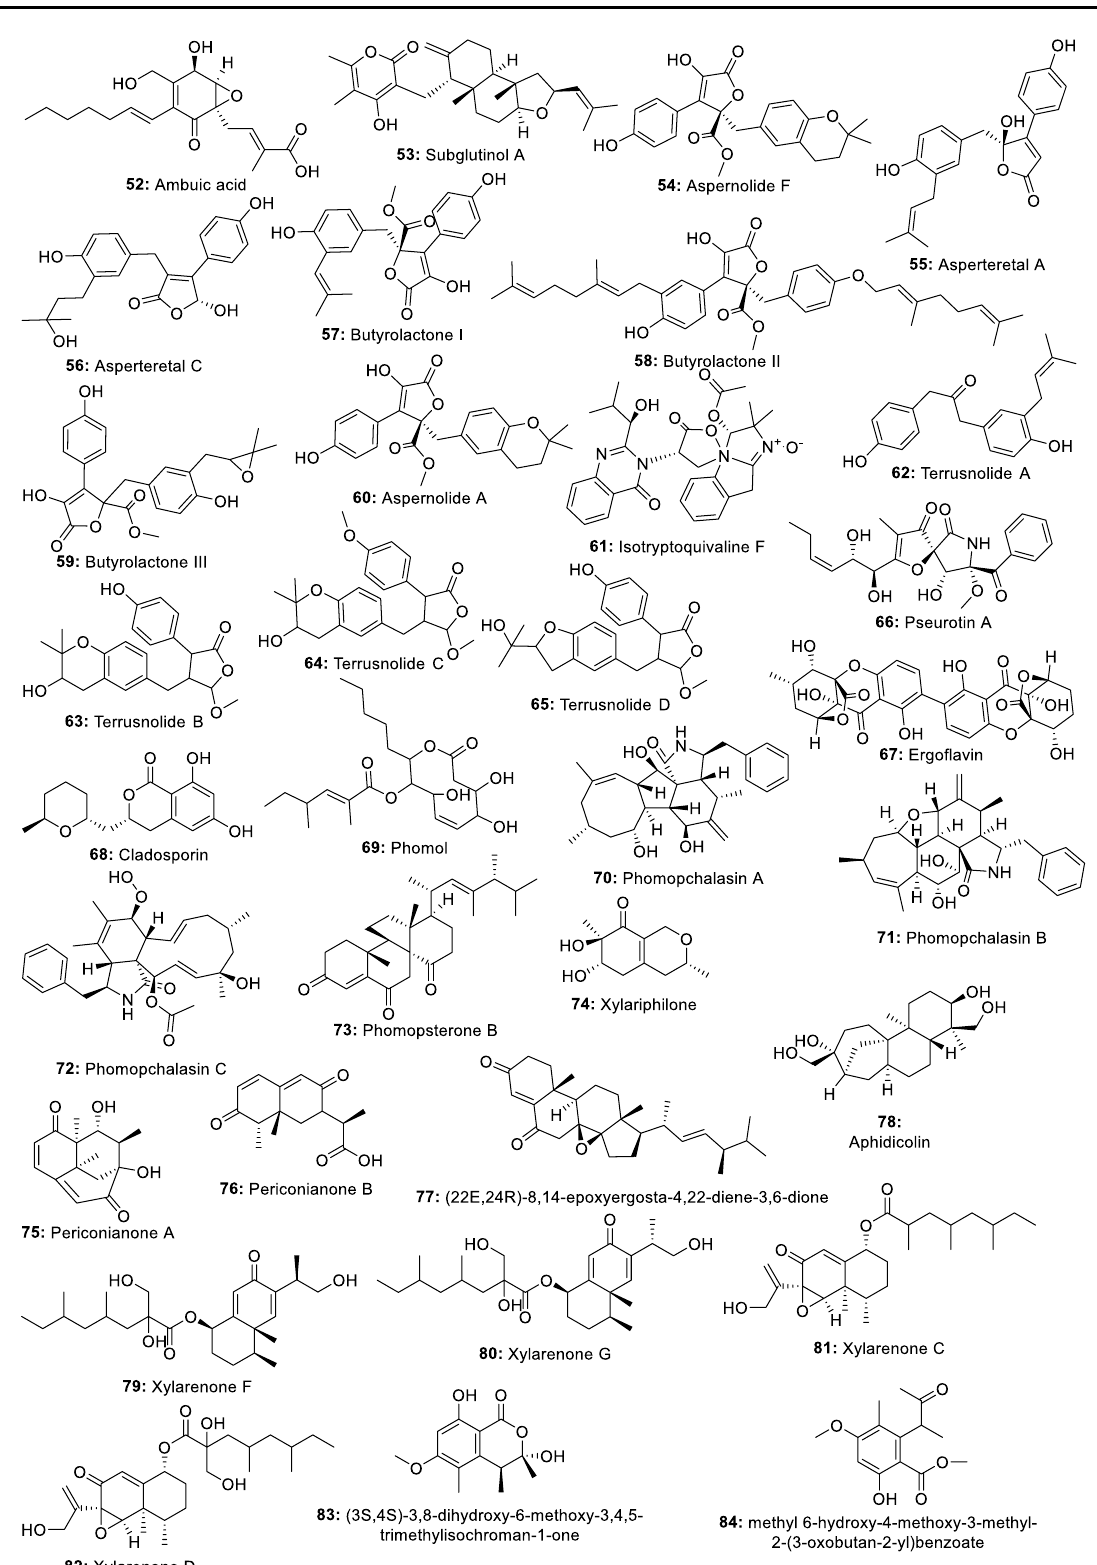
Fig. 3 Anti-inflammatory compounds isolated from endophytic fungi of terrestrial